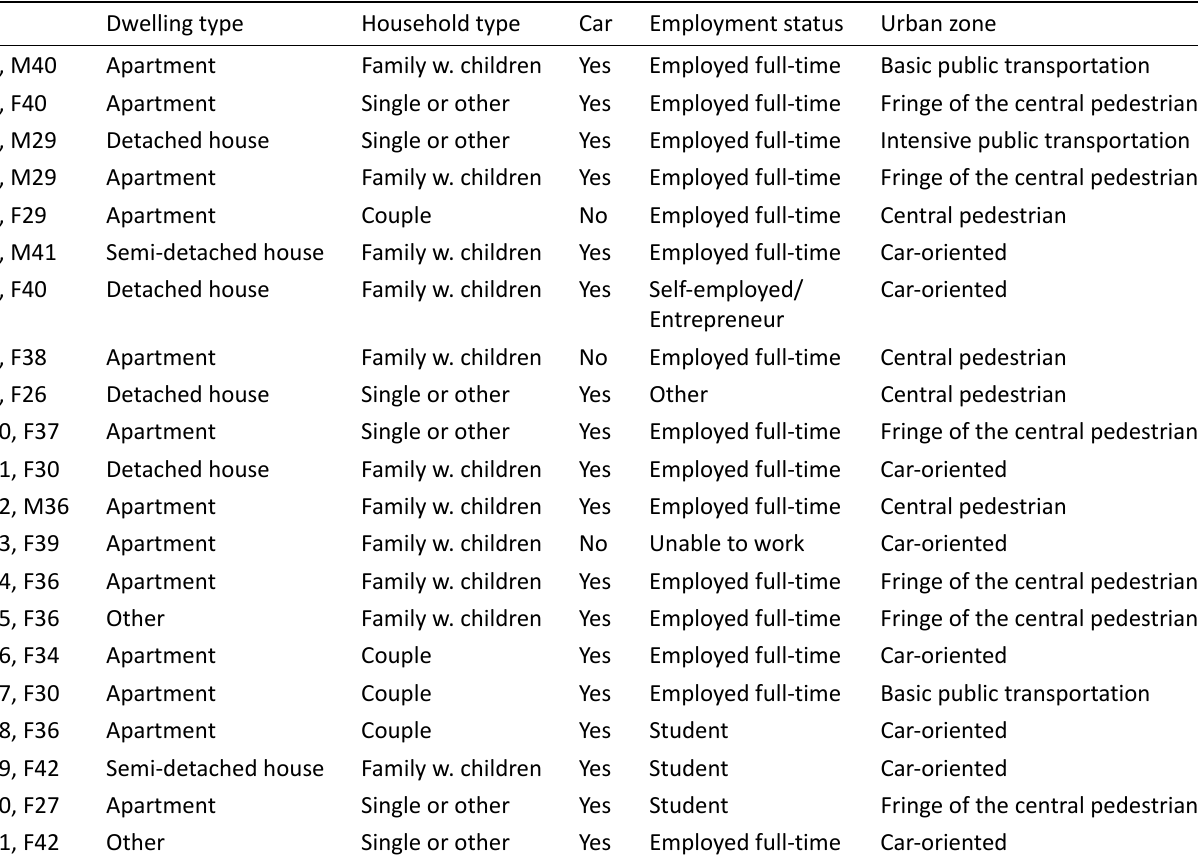
Table 1. Overview of respondents in the